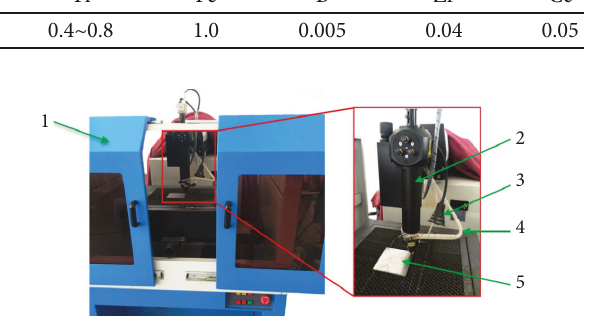
Figure 1: The appearance of laser cutting equipment (1 — machine housing, 2 — laser lens assembly, 3 — lighting, 4 — conveying pipe of auxiliary gas, and 5 —